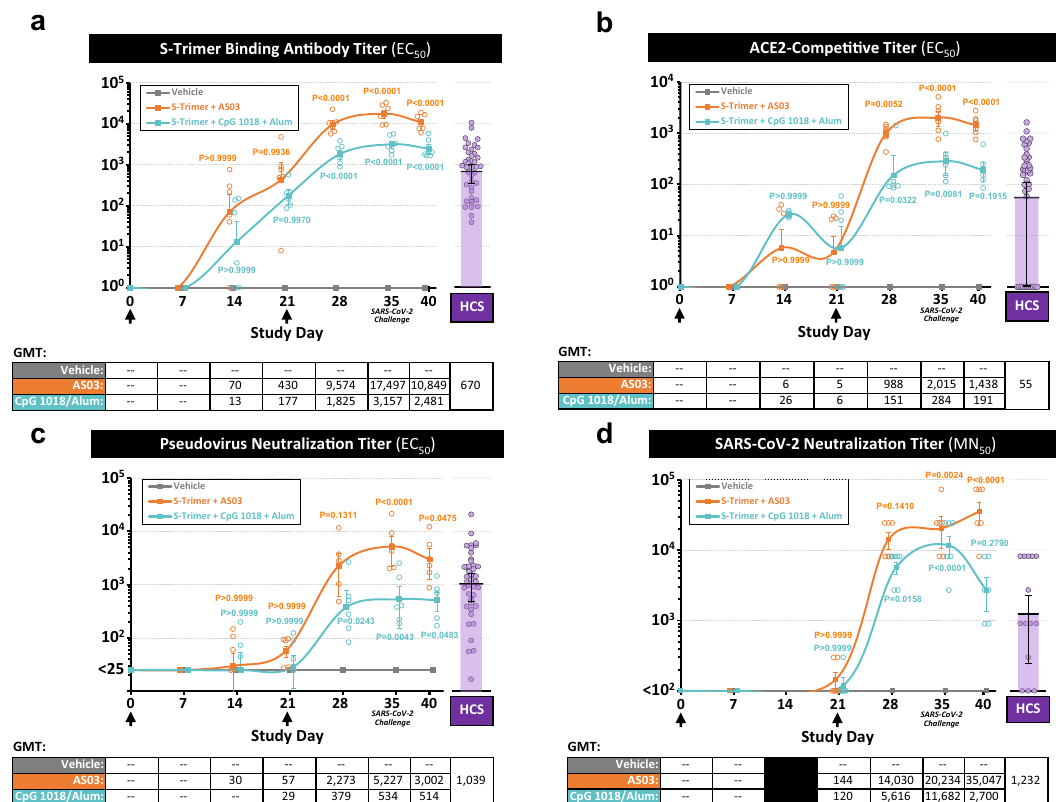
Fig. 4 Immunogenicity of S-Trimer in nonhuman primates. Rhesus macaques ( n = 6/group) were immunized with 30 µ g S-Trimer adjuvanted with 0.25 mL AS03, 30 µ g S-Trimer adjuvanted with 1.5 mg CpG 1018 plus 0.75 mg alum, or PBS vehicle control twice on Day 0 and Day 21 and were challenged on Day 35 with 2.6 × 10 6 TCID50 (60% intranasal and 40% intratracheal) live SARS-CoV-2 virus. The humoral immune responses and kinetics were analyzed and compared with a human convalescent sera (HCS) panel, based on a S-Trimer binding antibody ELISA titers, b ACE2-competitive ELISA titers, c SARS- CoV-2 pseudovirus neutralization titers, and d wild-type SARS-CoV-2 virus neutralization titers. Circular points represent individual animals and humans; kinetics data are presented as geometric mean titers (GMT) ± SEM. For statistical analysis of antibody titers, all comparisons were made against the vehicle negative control group with Two-way ANOVA multiple comparisons test. P values < 0.05 were considered signi fi